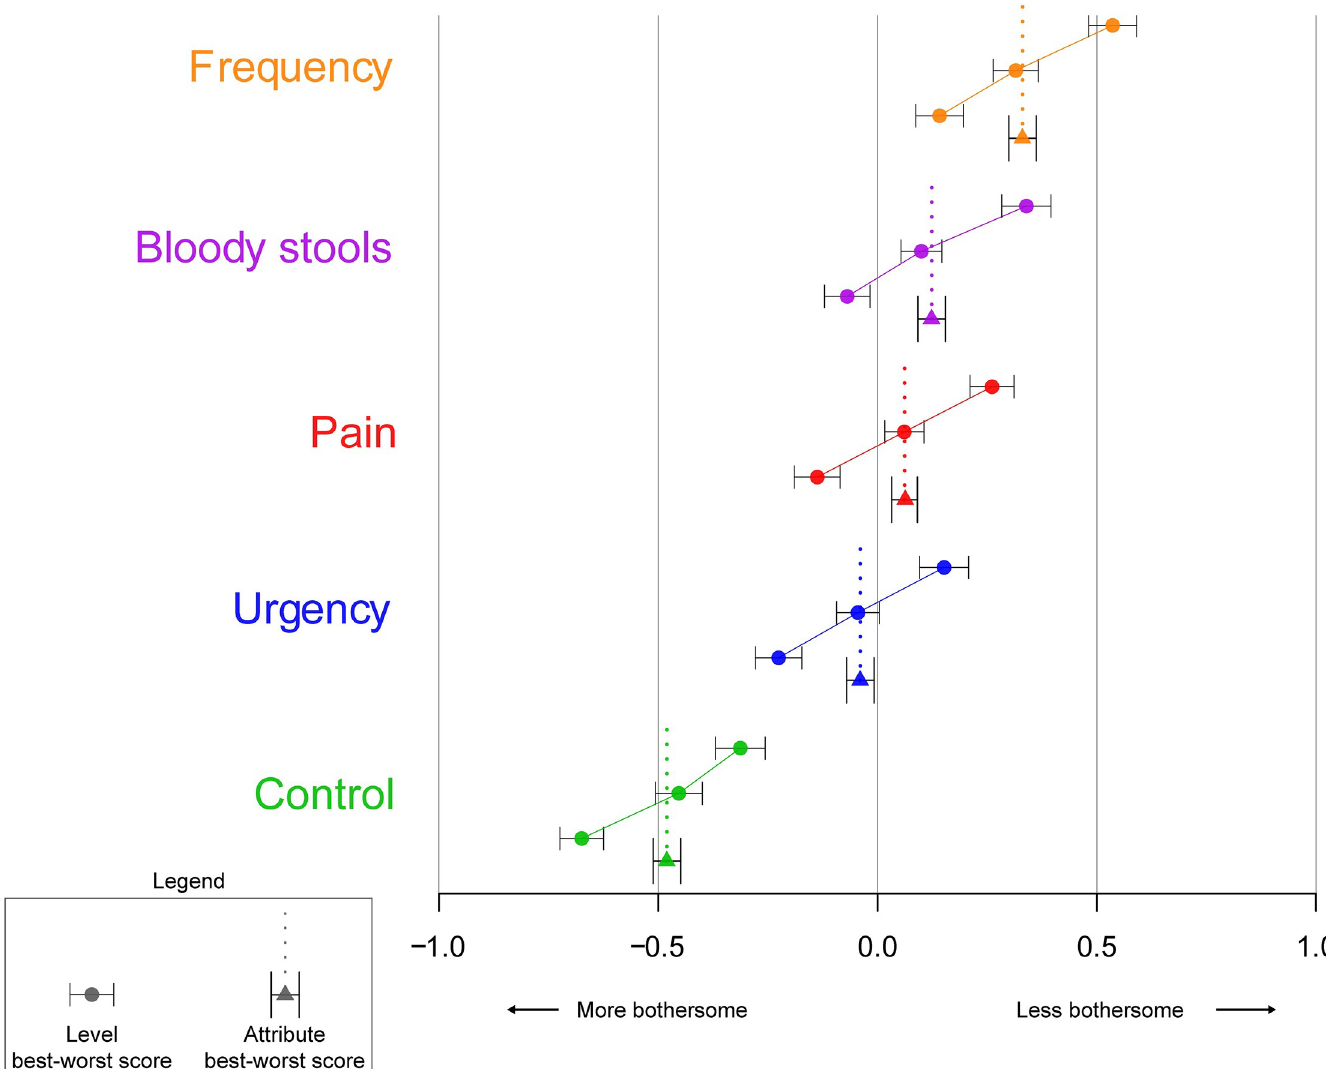
Fig 3. Best worst counts and scores for attribute levels and